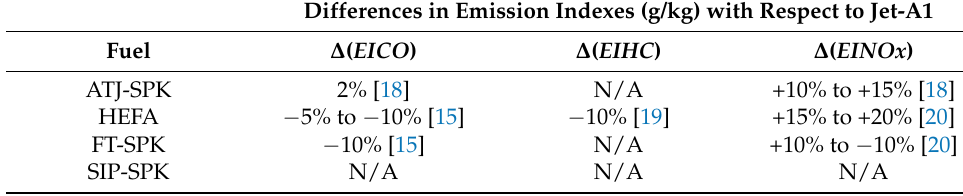
Table 2. Differences in emission indexes (g/kg) with respect to